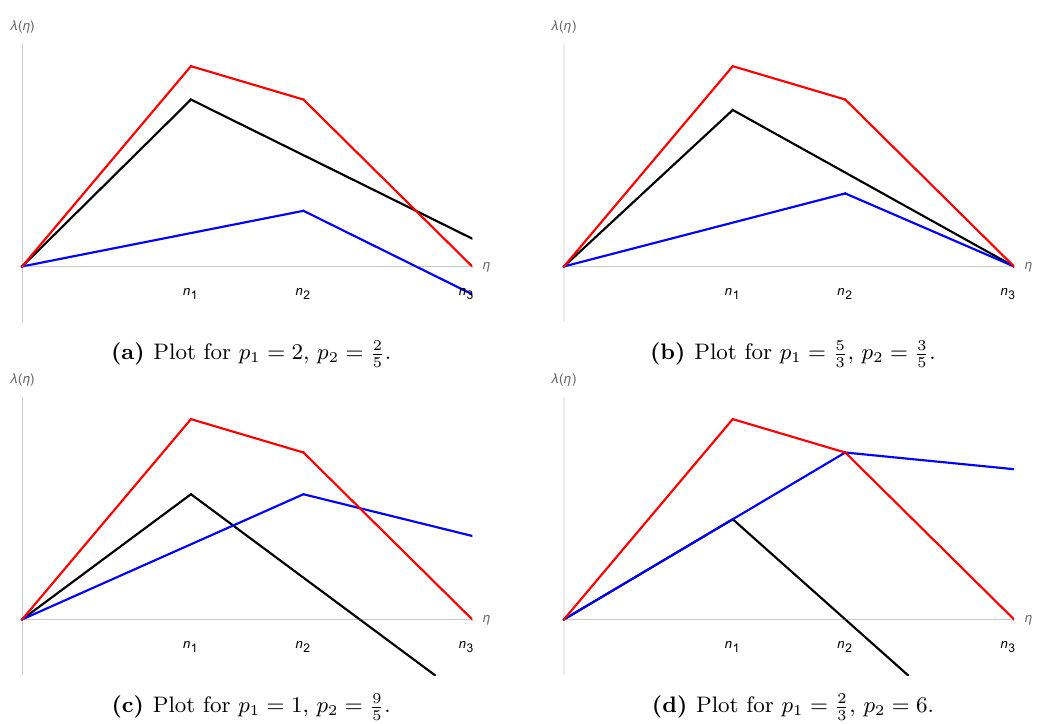
Figure 3. We plot various choices of the building blocks giving rise to the same theory. The red line is the line charge of the composite potential which is identical in all four figures with end-point n 3 = 8 . The black line is the line charge of the first building block giving the kink at n 1 = 3 with change of slope l 1 = 15 . The blue line is the second building block with kink at n 2 = 5 and change of slope l 2 = 7